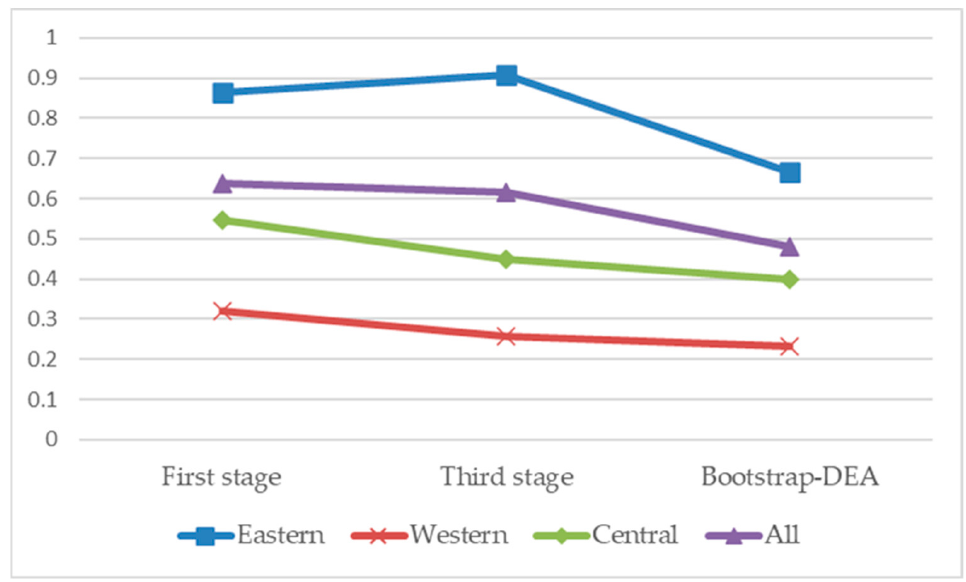
Figure 1. Change path for regional shipping efficiency value.